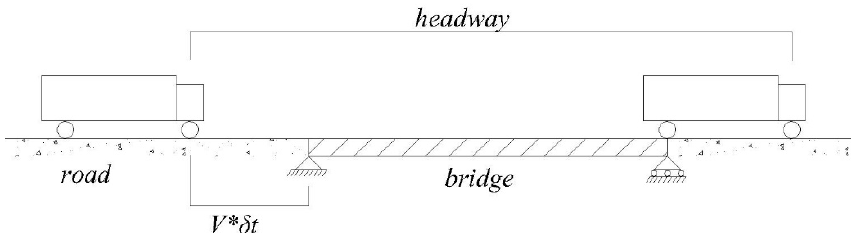
Figure 6. Schematic showing the definition of time lag ( δ t ) between the lead vehicle departure and following vehicle arriving on the bridge (V = speed).